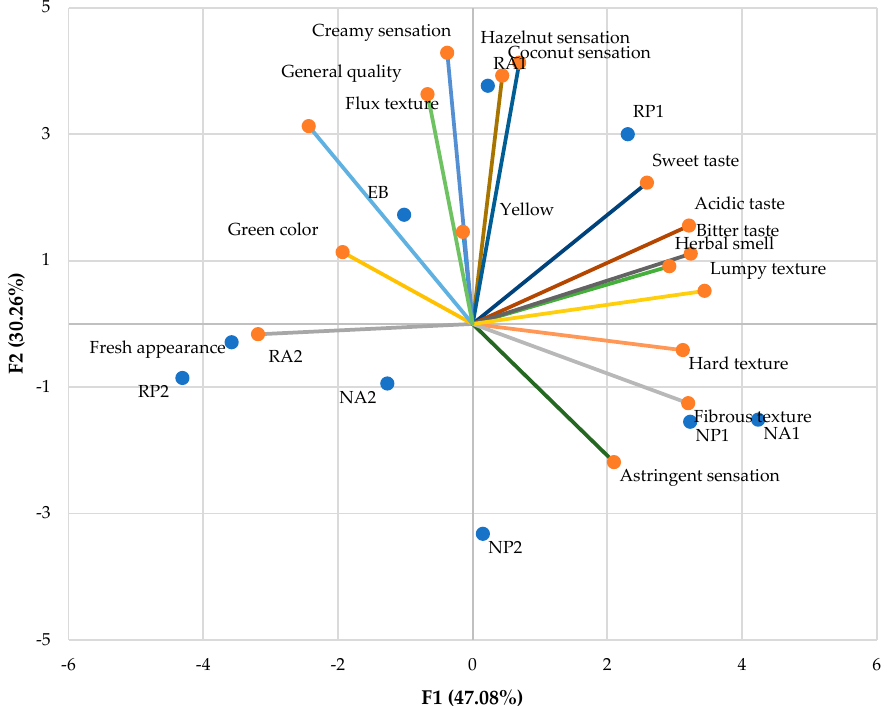
Figure 8. Sensory profile of fruits from different orchards under different nutrient management (P and A) and growth cycle (1 and 2) conditions. Orchards: EB, N, and R. A: Nutrient management based on the Balanced Indices of Kenworthy (BIK). P: Nutrient management of the farmer. 1. Harvest from the intermediate flowering period. 2. Harvest from the main flowering period.